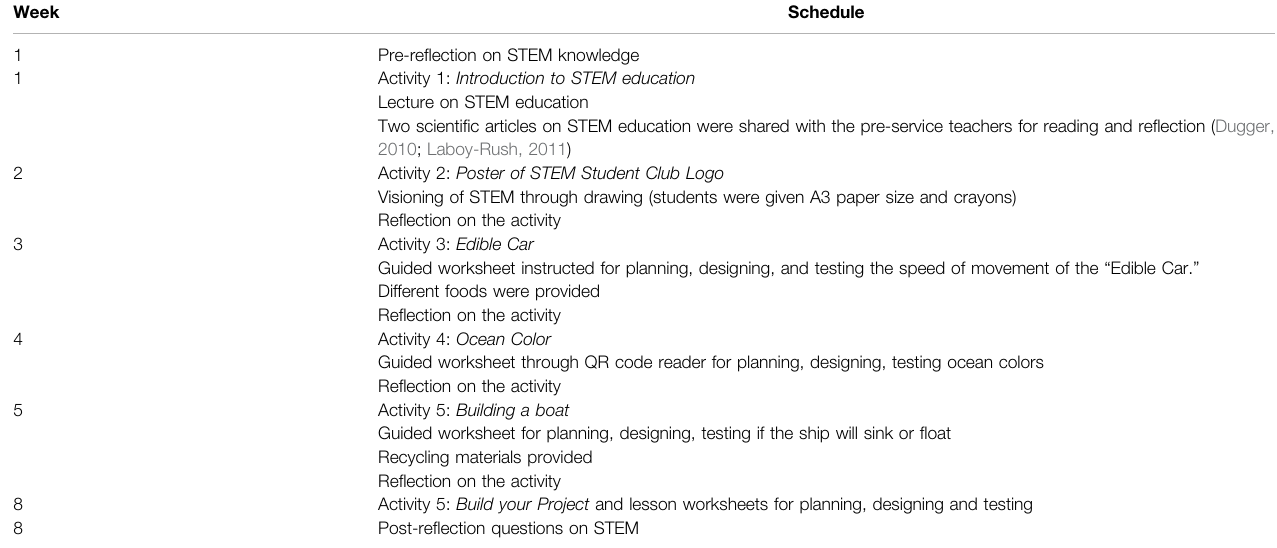
TABLE 1 | The activities for the STEM professional development workshop (Akaygun and Aslan-Tutak,